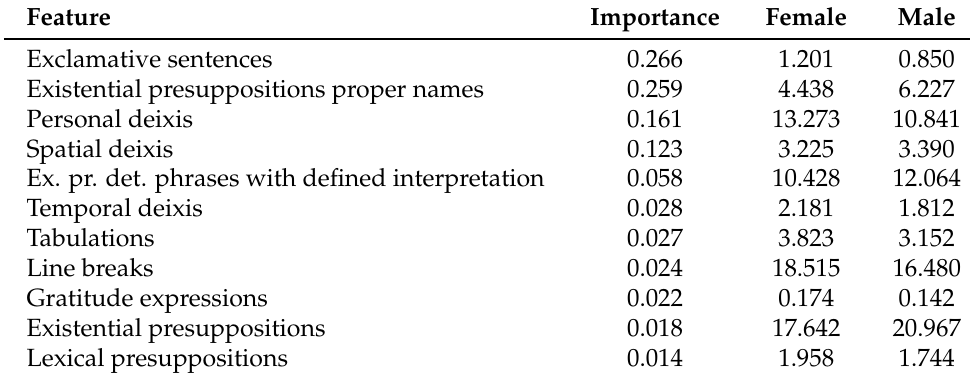
Table 9. Pragmatics-discursive feature importance and mean